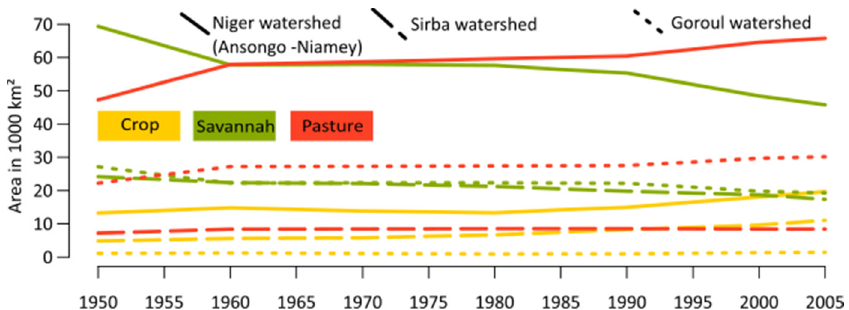
Figure 3. Changes in the main land use classes of crop, savannah, and pasture from 1950 until 2005 for the watershed of the Niger River between Ansongo and Niamey, and the catchments of the Sirba and Goroul Rivers (see area in Figure